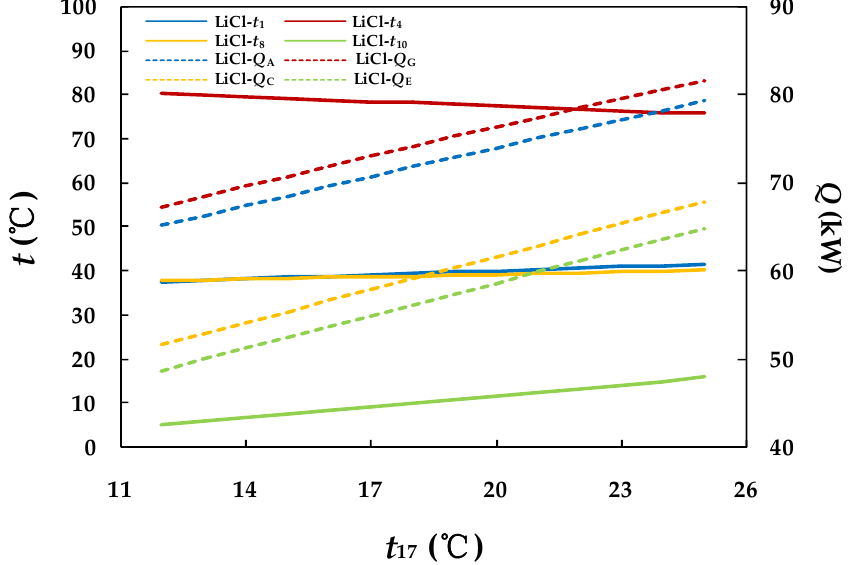
Figure 20. Variation of the exit temperature and heat capacity of each component with the chilled water inlet temperature for the LiBr-H 2 O absorption chiller.